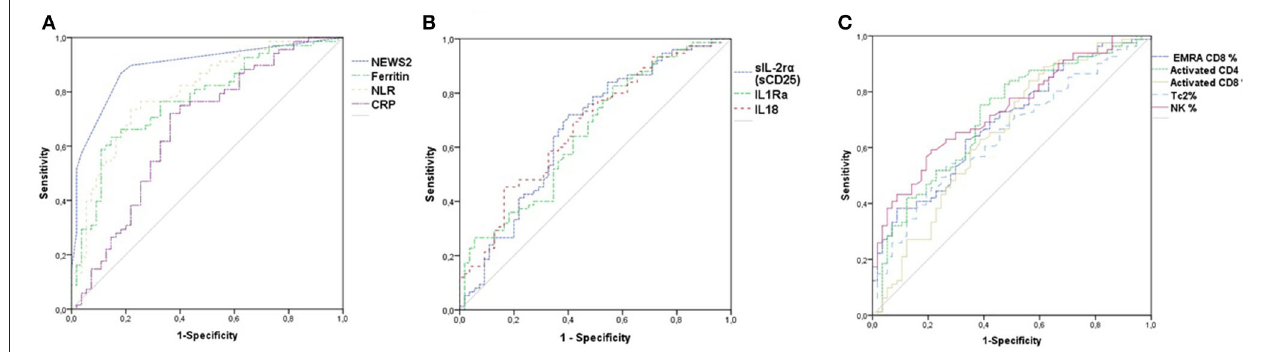
FIGURE 5 | Performance of ROC curves in predicting severe/critical COVID-19 disease for News-2, Ferritin, NLR and CRP (A) , sCD25s, 111Ra, and IL1S (B) and activated CD4 and CDS, NK, Tc2 and EMRA CDS (C) .